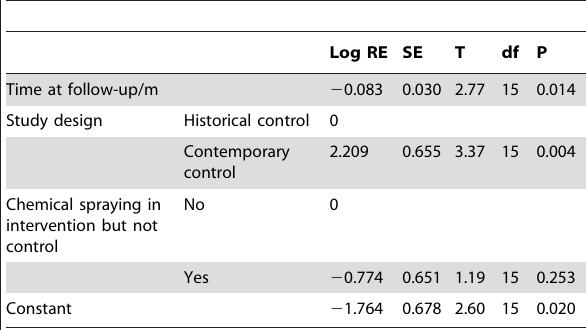
Table 2. Final model showing impact of modifiers on relative effectiveness of intervention on entomological indices. a